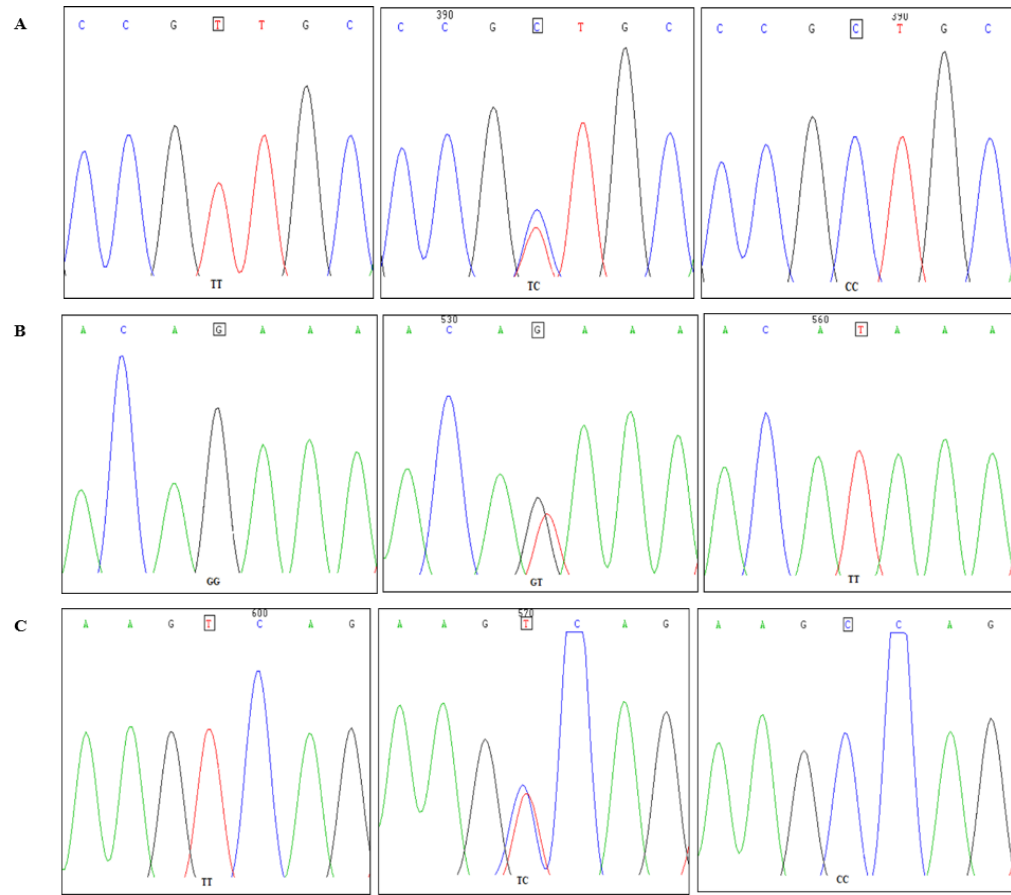
Figure 2. Analysis result chart of 3 SNPs site. ( A ): T − 550c peak alignment; ( B ): G − 398T peak alignment; ( C ): T − 360C peak alignment.